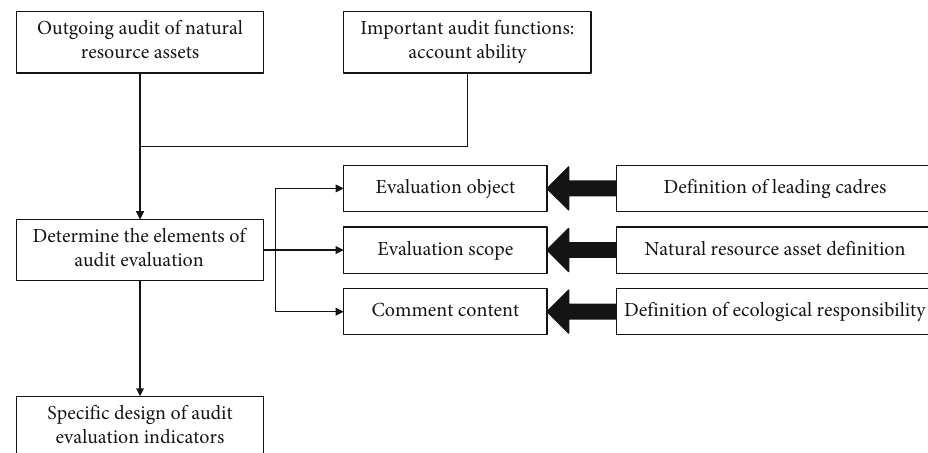
Figure 1: Framework diagram of indicator construction thinking